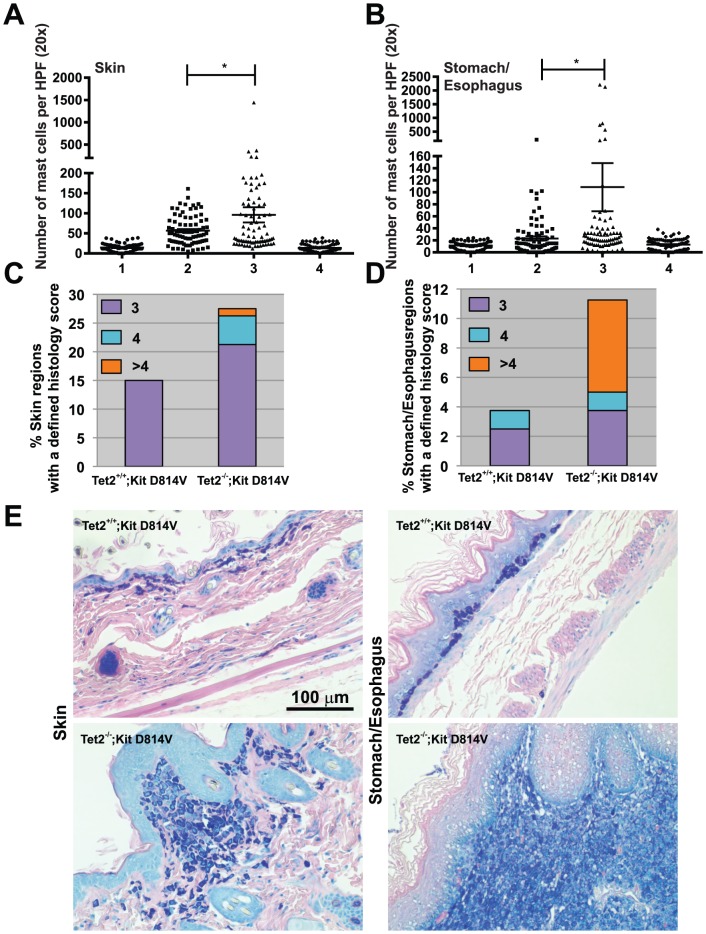
Loss of Tet2 accentuates a Kit D814V driven mast cell phenotype.
A) Average number of mast cells per skin section across genotypes. N = 60–80 sections from 3–4 independent animals/genotype. *P<.05. B) Average number of mast cells per stomach/esophagus section across genotypes. N = 60–80 sections from 3–4 independent animals/genotype. *P<.05. For Figure 2A and 2B, numbers 1–4 indicate the following genotypes: 1 = WT ctr, 2 = Tet2+/+;Kit D814, 3 = Tet2−/−;Kit D814, 4 = Tet2−/−;Kit WT. C) Percentage of skin sections with a defined histology score from Tet2+/+;Kit D814V and Tet2−/−;Kit D814V. D) Percentage of stomach/esophagus sections with a defined histology score in Tet2+/+;Kit D814V and Tet2−/−;Kit D814V animals. For Fig 2A–2D, twenty randomly chosen and independent regions of equal thickness per animal were counted in a blinded fashion at 20× magnification, and scored according to the classification reported in Table 1. Mice were all harvested between 8 and 20 weeks after the last pI:C injection. n = 4 per genotype. E) Representative pictures of Giemsa staining performed on skin (left panels) or stomach/esophagus sections (right panels) prepared from Tet2+/+;Kit D814V and Tet2−/−;Kit D814V animals. Mast cells stain dark blue in these sections. Scale bar represents 100 µm.